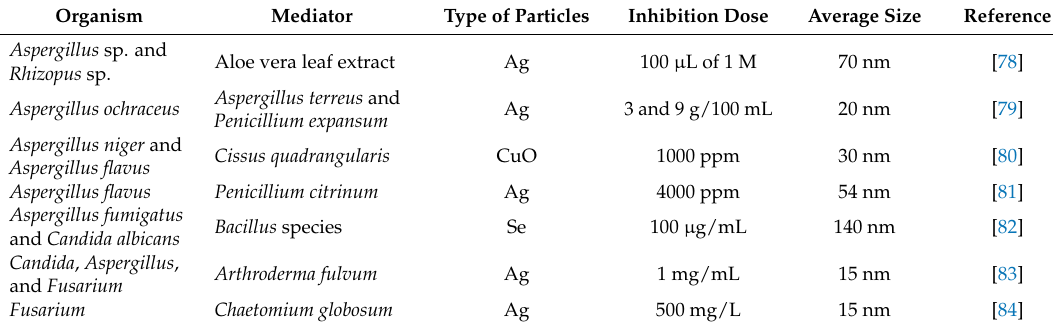
Table 2. Antifungal green synthetized